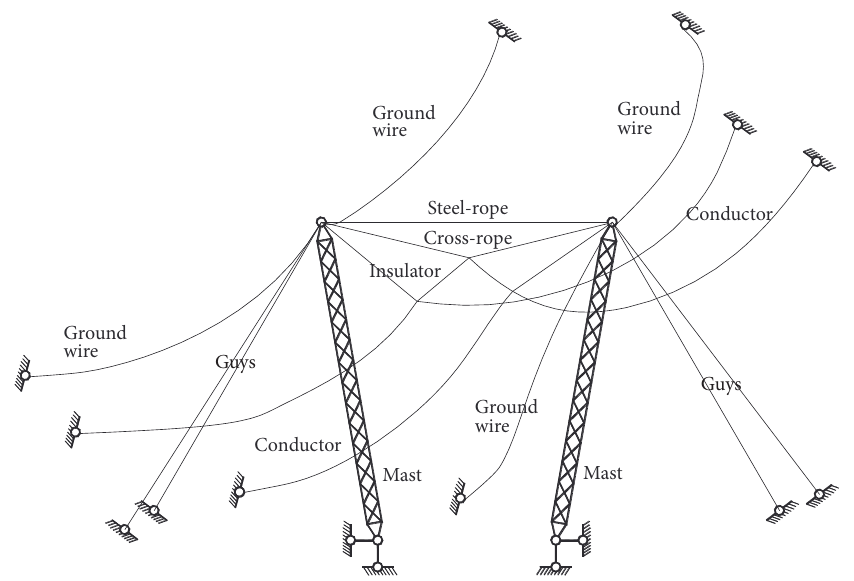
Figure 1: Schematic diagram of cross-rope suspension tower.